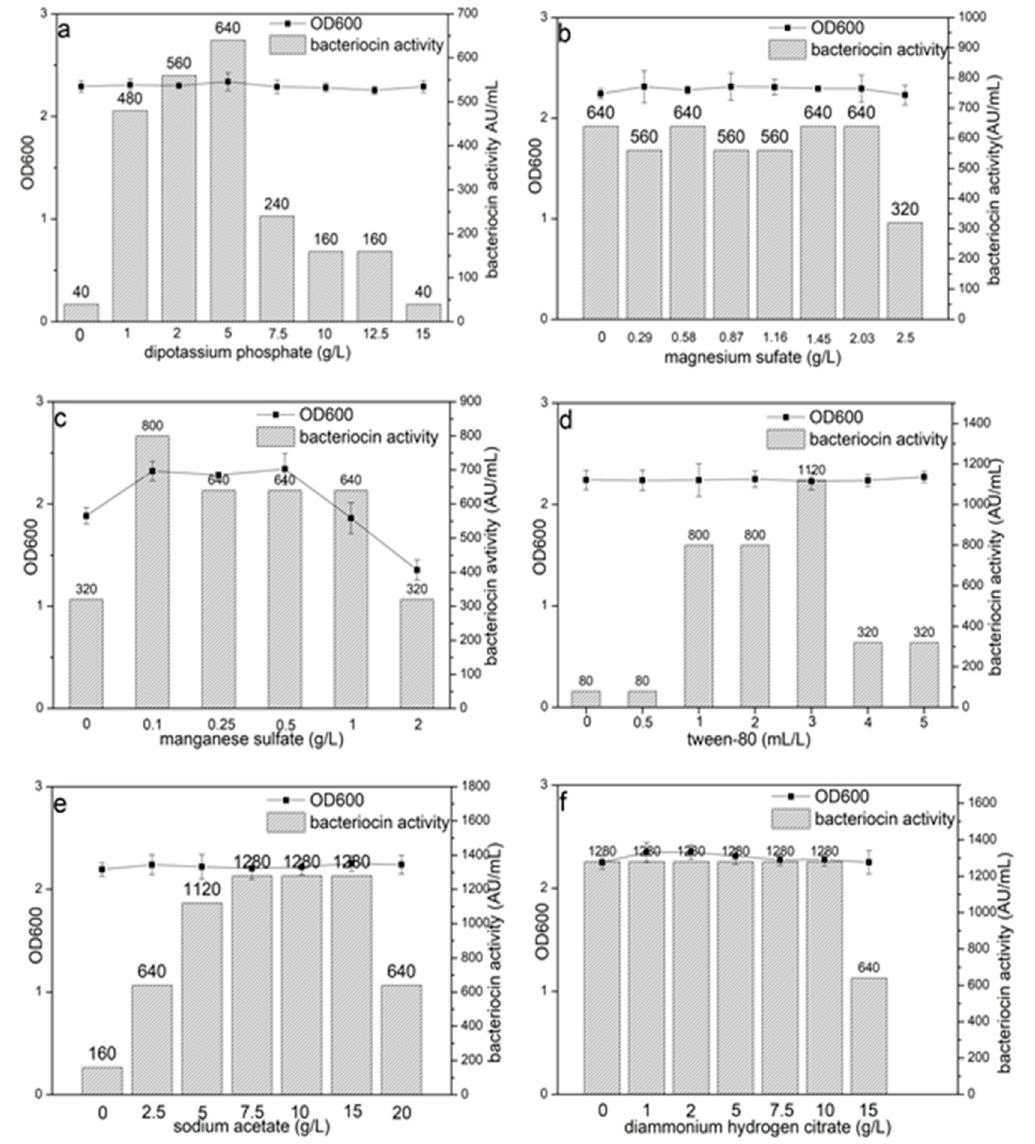
Figure 1. Effects of the ingredients of the De Man, Rogosa and Sharpe (MRS) broth on the growth of Lactobacillus plantarum J23 and bacteriocin Lac-B23 production. Note: ( a ) is dipotassium phosphate, ( b ) is magnesium sulfate, ( c ) is manganese sulfate, ( d ) is Tween 80, ( e ) is sodium acetate and ( f ) is diammonium hydrogen citrate. Values listed are the averages of three experiments.